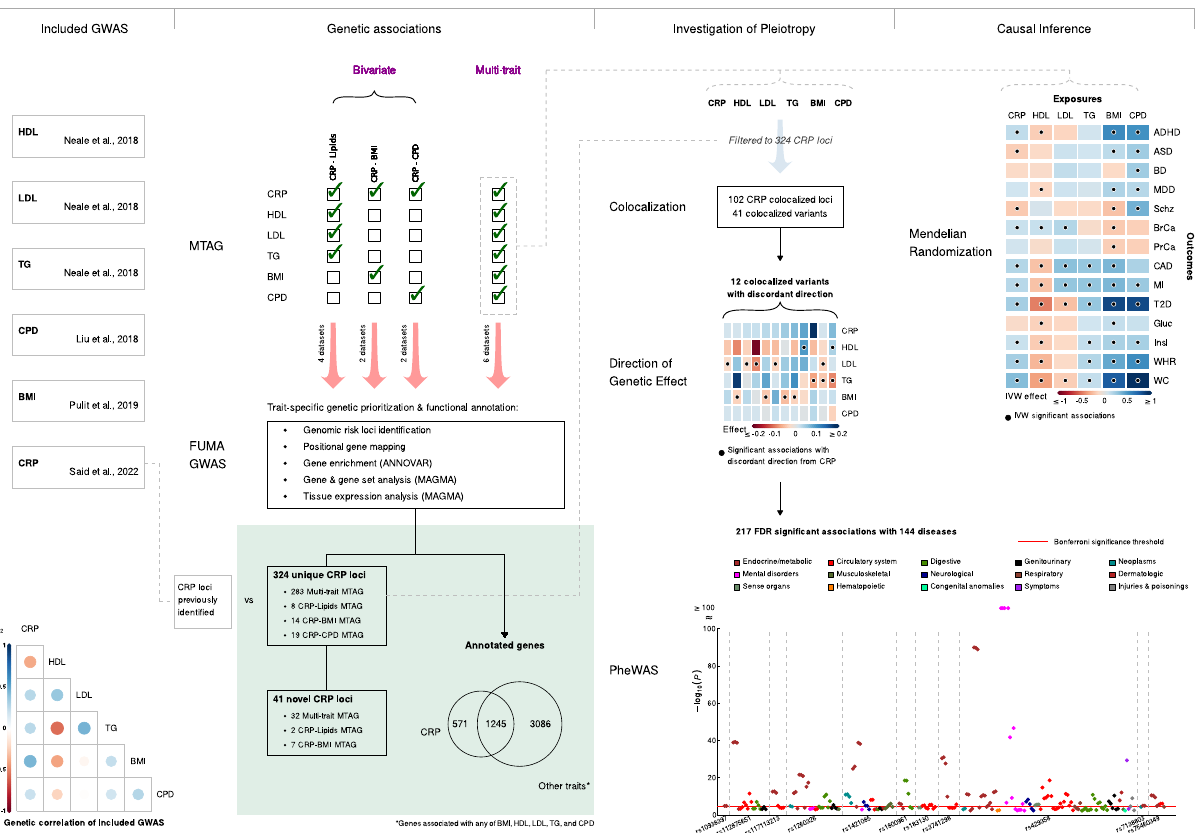
Fig. 1 | Study design schematic for the discovery of novel CRP loci and inves- tigation of pleiotropic loci. BMI Body mass index, CPD Cigarettes per day, CRP C-reactive protein, HDL high-density lipoprotein, LDL low-density lipoprotein, TG triglycerides, ADHD attention de fi cit hyperactivity disorder, ASD autism spectrum